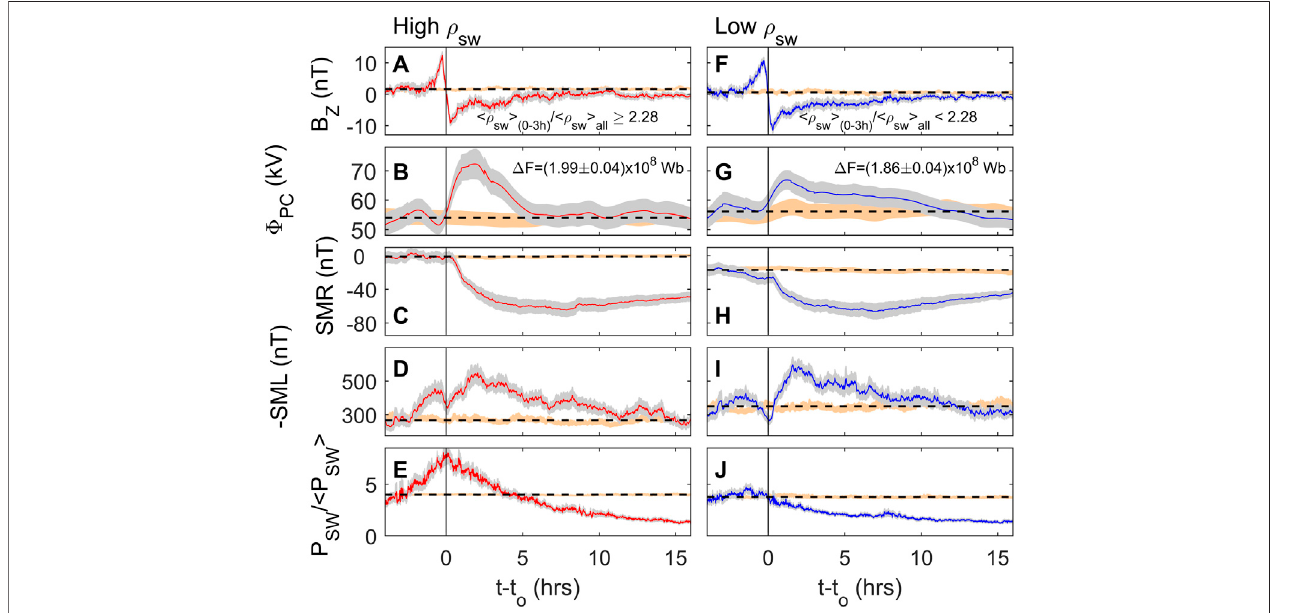
FIGURE 12 | The same as Figure 9 but with the 160 southward turning events sorted by the solar wind mass density, ρ SW . The left hand panel are for the events withnormalized ρ